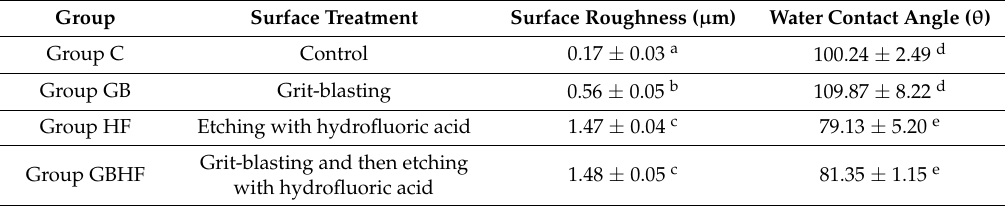
Table 1. Surface roughness ( R a ) ( n = 20) and water contact angle ( θ ) ( n = 20) of different groups (mean ± standard deviation).